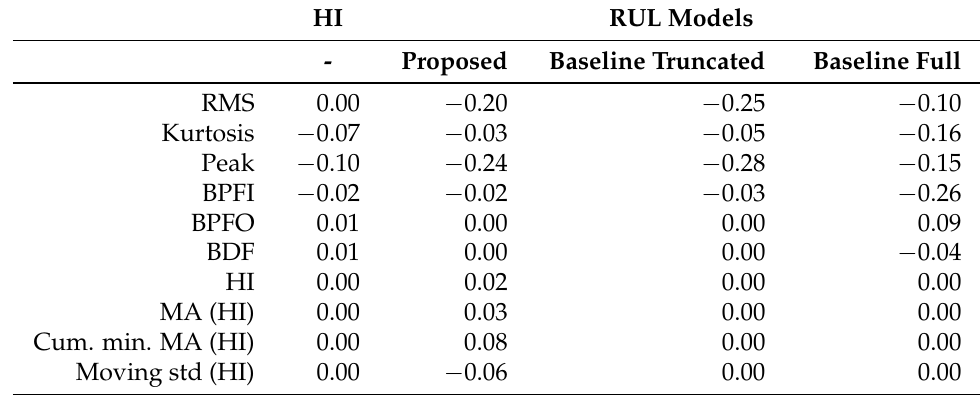
Table 7. Coefficients for SMLL